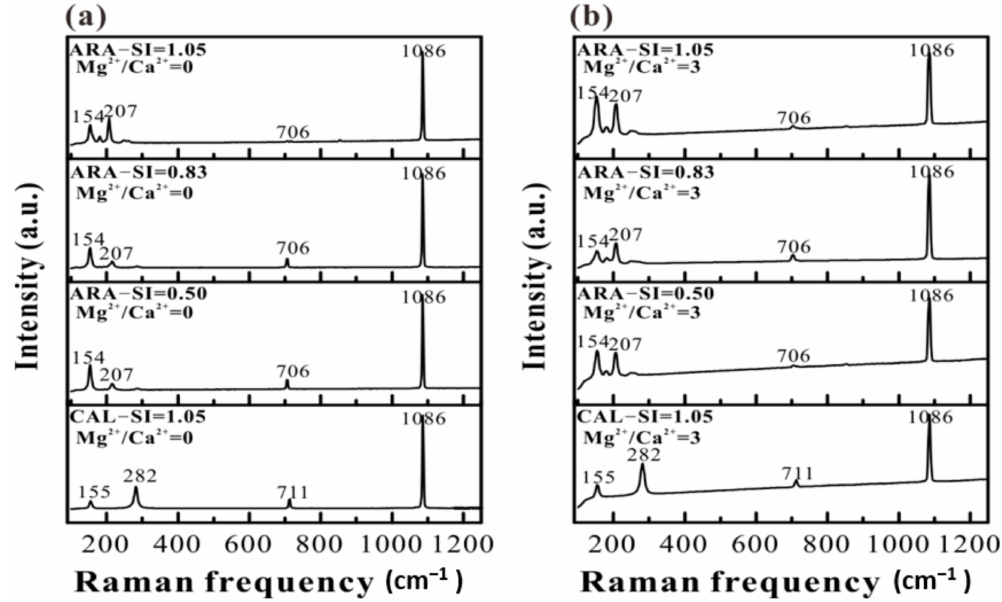
Figure 11. Raman spectra of the calcite (104) and aragonite (110) substrates after growing in solutions at SI calcite = 0.50–1.05 with ( a ) Mg 2 + / Ca 2 + = 0, and ( b ) Mg 2 + / Ca 2 + =